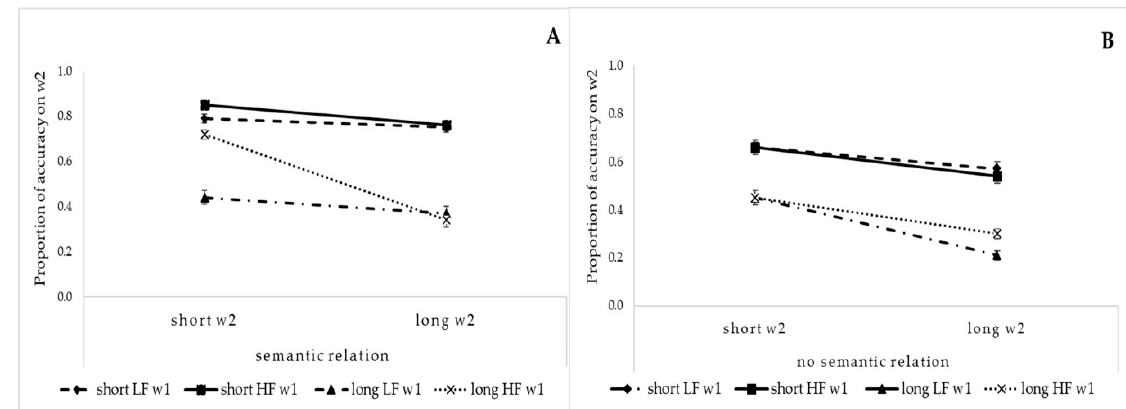
Figure 2. Accuracy on w2 as a function of w1 length and frequency in the semantically related condition (Panel A ) and in the semantically unrelated condition (Panel B ). LF = low-frequency; HF = high-frequency.